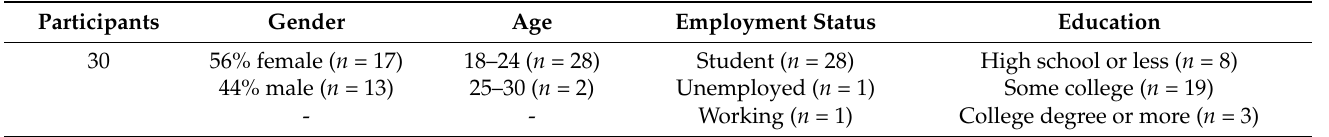
Table 1. Characteristics of the